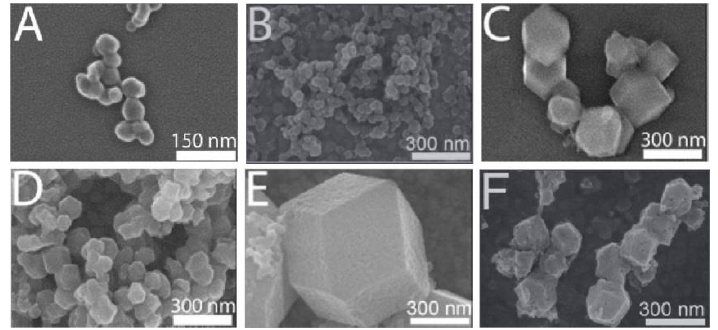
Figure 1. ZIF-90 nanoparticles (NPs) synthesized in trioctylamine at ( A ) 0 °C, ( C ) 100 °C, and ( E ) 150 °C and particles synthesized at room temperature using ( B ) trioctylamine, ( D ) tributylamine, ( F ) trimethylamine [12]. Reprinted (adapted) with permission from (Versatile Synthesis and Fluorescent Labeling of ZIF-90 Nanoparticles for Biomedical Applications). Copyright (2016) American Chemical Society.